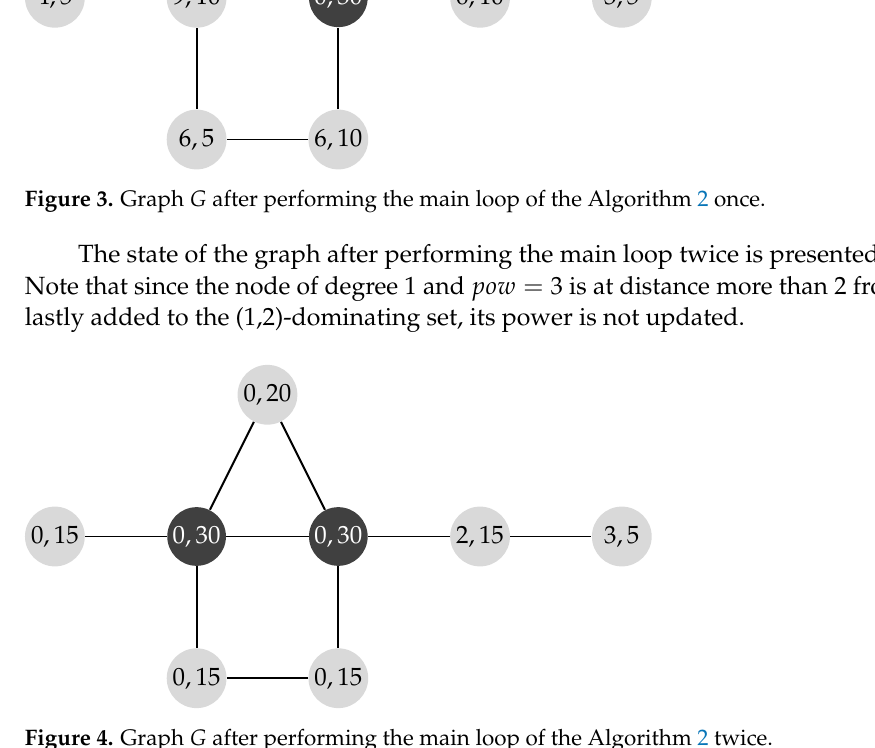
Figure 4. Graph G after performing the main loop of the Algorithm 2 twice.